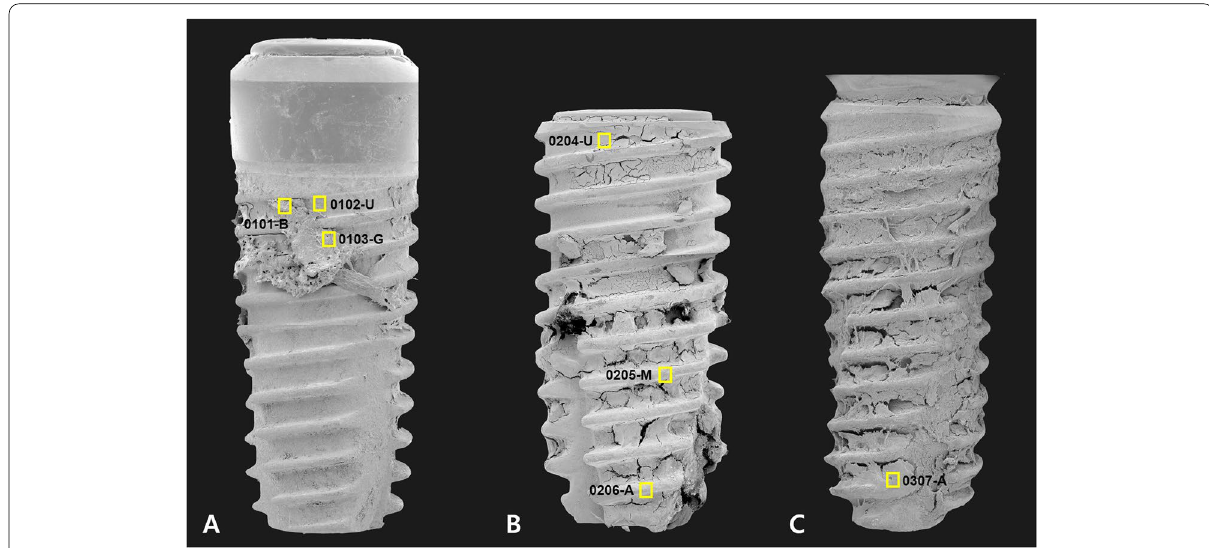
Fig. 4 SEM photograph of three fixtures at 65 magnification with points established by SEM–EDS marked. For fixture no. 01 ( A ), × high-magnification SEM photography and EDS analysis were performed at the following three points: integrated bone tissue at the upper region (0101-B), implant surface at the root area of the upper region (0102-U), and grafted bone at the second thread of the upper region (0103-G). For fixture no. 02, the analysis was performed at three points in the upper region (0204-U) and the top of the thread in the middle (0205-M) and apical regions (0206-A). For fixture no. 03, one analysis was performed at the bone tissue in the apical region of the fixture